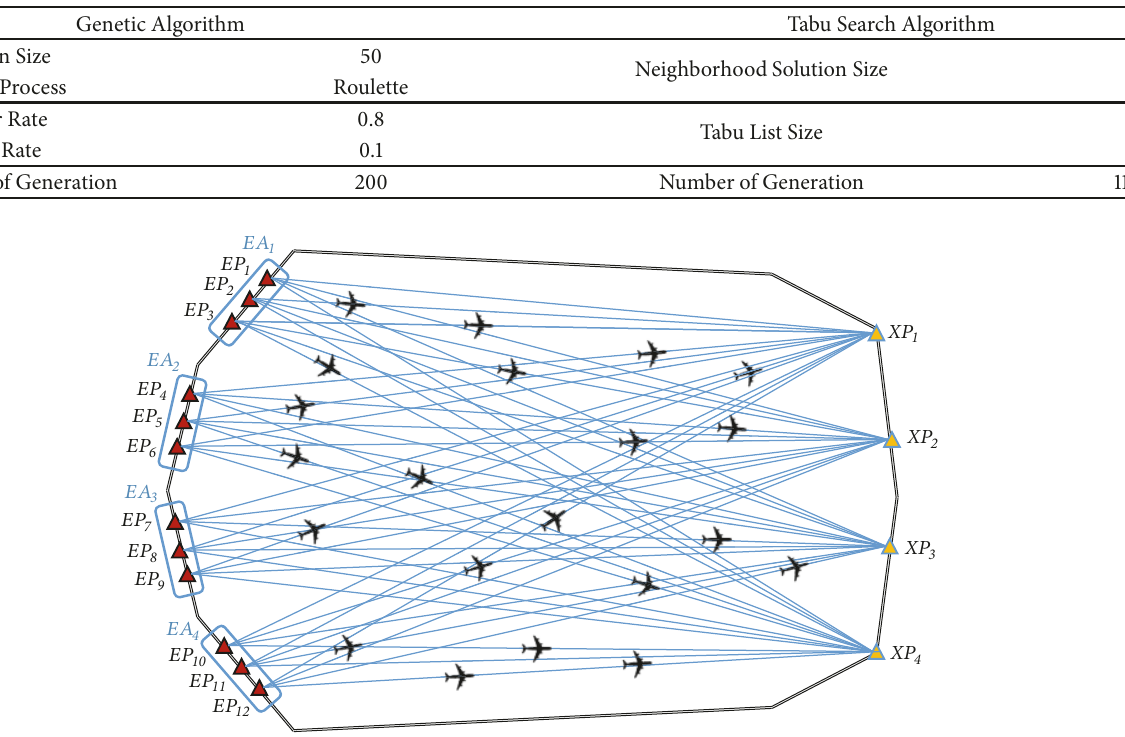
Figure 9: Complex airspace